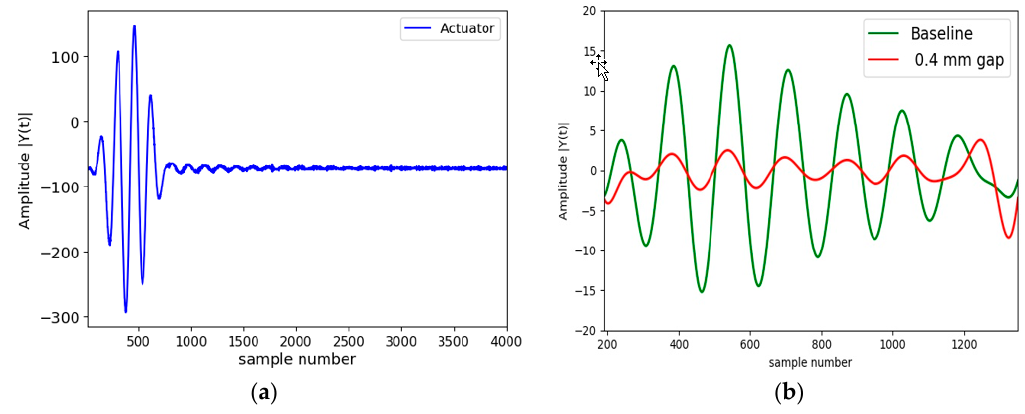
Figure 4. ( a ) Actuation signal and ( b ) sensor signal in steel-concrete composite structure.